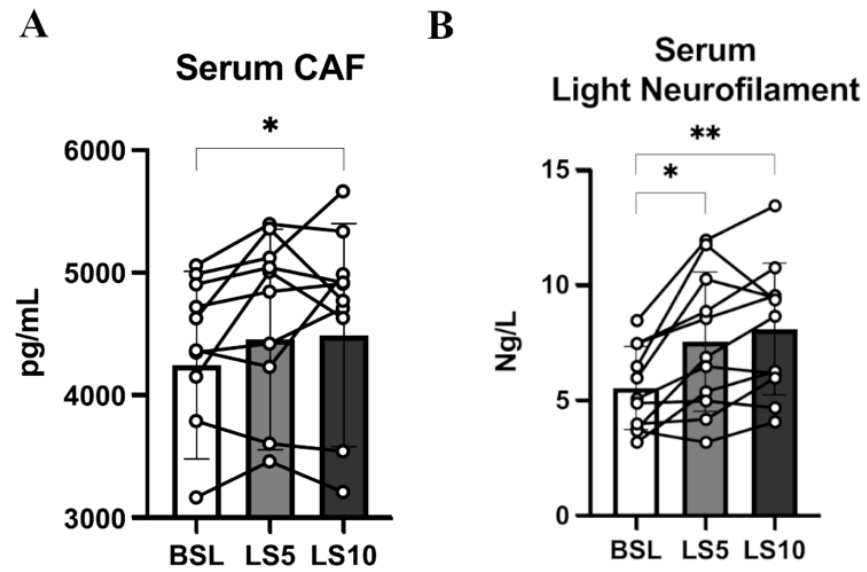
Figure 6. ( A ) Serum level of CAF at BSL, 5 days and 10 days after ULLS. ( B ) Serum level of light neurofilament at BSL, 5 days after ULLS and 10 days after ULLS. Error bars represent standard deviations. Asterisks (*) indicate statistical significance at p < 0.05. Two asterisks (**) is for significance at p < 0.01. Experiments were performed in duplicates. n = 11 male subjects; one-way